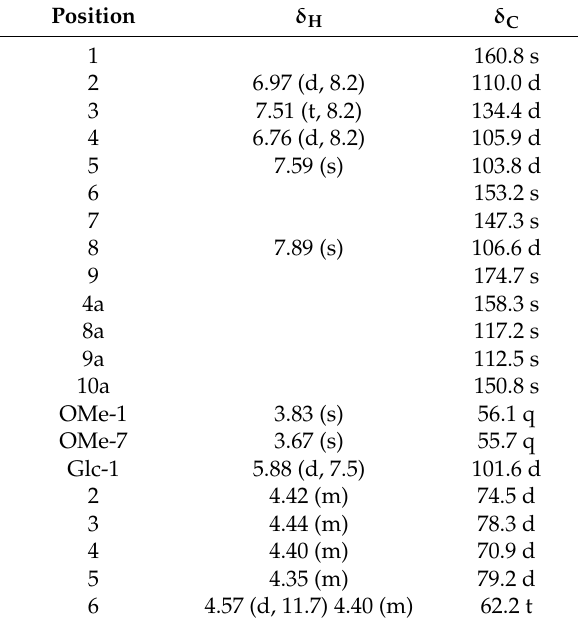
Table 2. The 1 H (600 MHz) and 13 C-NMR (125 MHz) data of C in DMSO- d 5 .